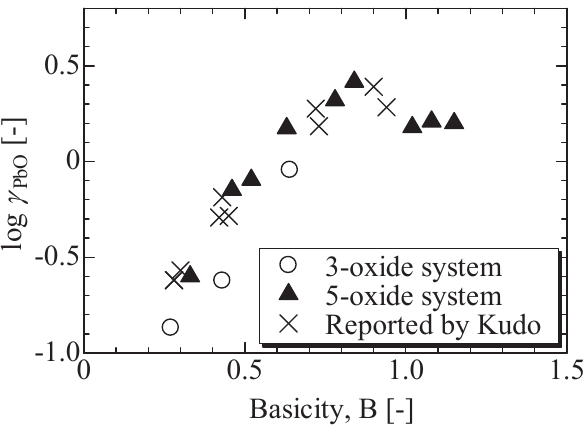
Figure 4. Comparison of the activity coefficient of PbO with previous research results for F D 0.35–0.44.